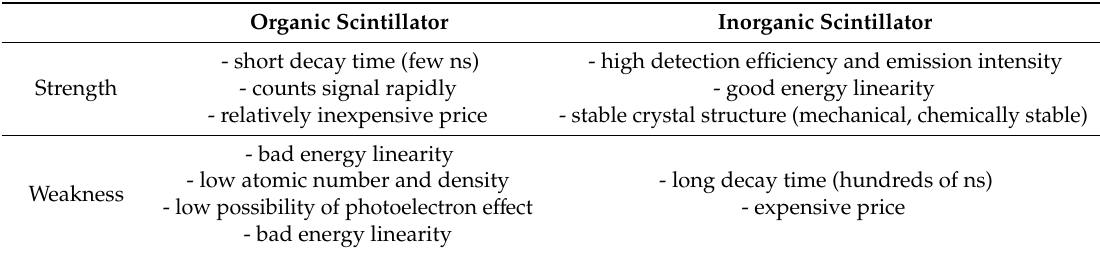
Table 3. Comparison of an organic scintillator and inorganic